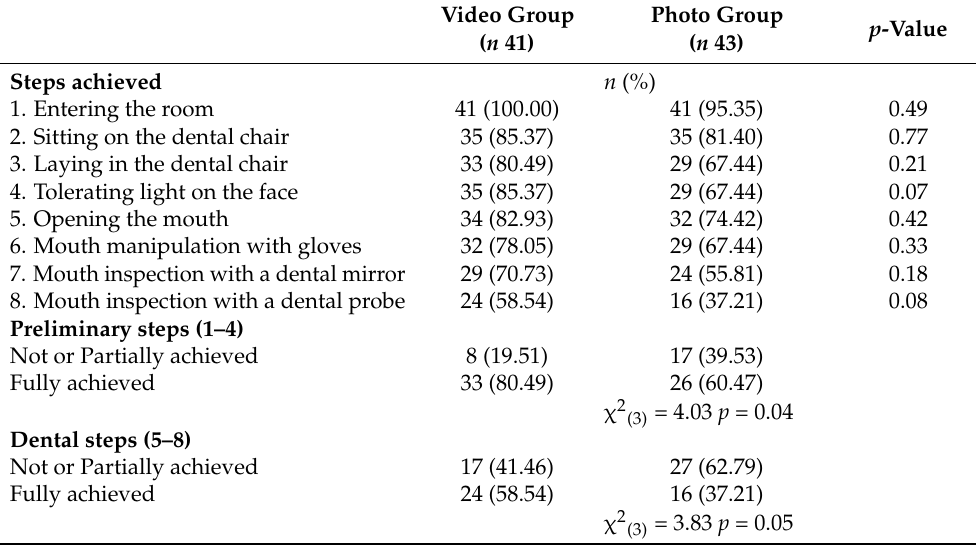
Table 3. Number of subjects who overcame each step and divided in Preliminary and Dental steps partially or not achieved and fully achieved in the two groups.